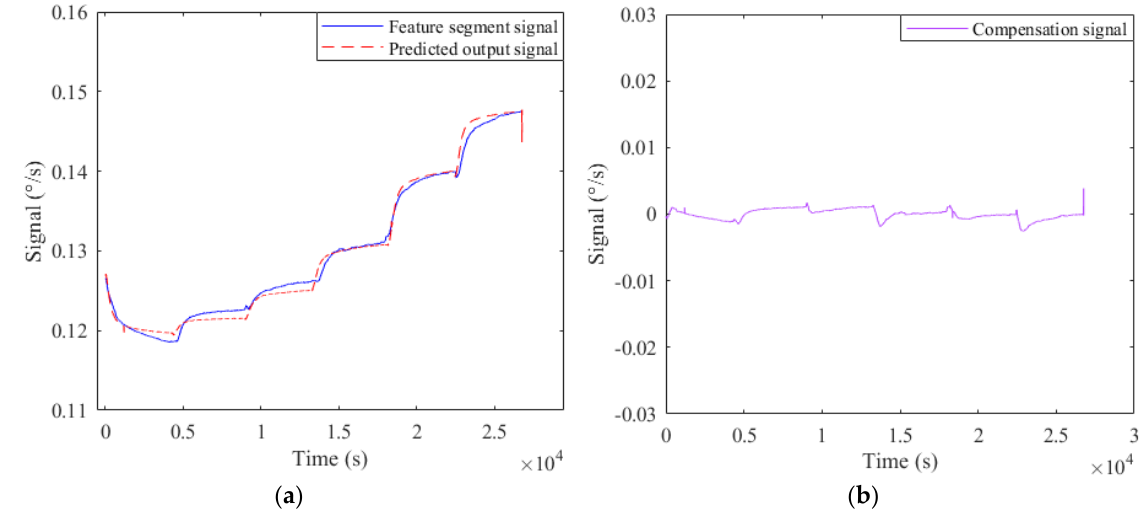
Figure 17. ( a ) Predicted output of drift segment; ( b ) Compensation result of drift segment.